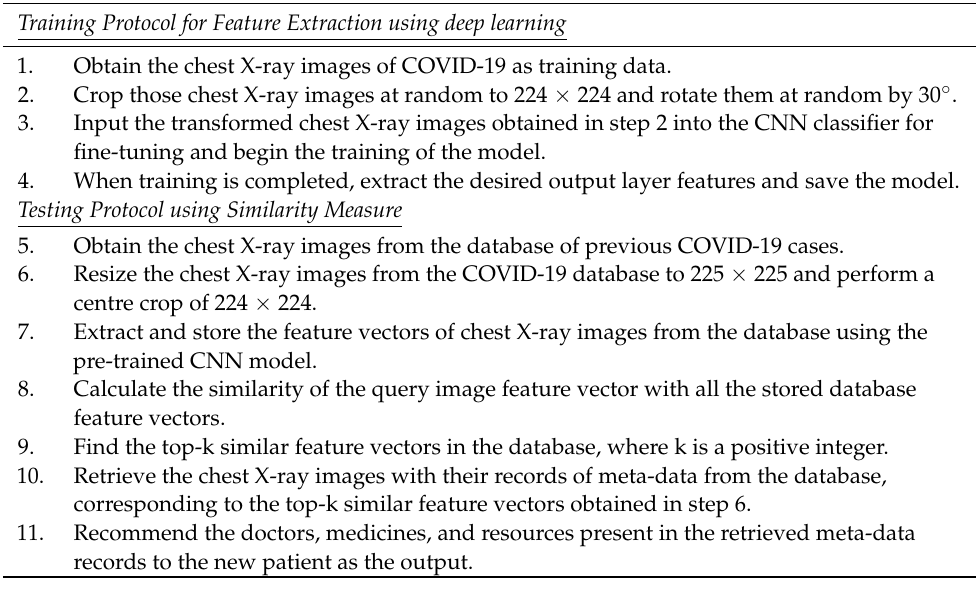
Algorithm 1: The Overall Algorithm of the Proposed System Training Protocol for Feature Extraction using deep